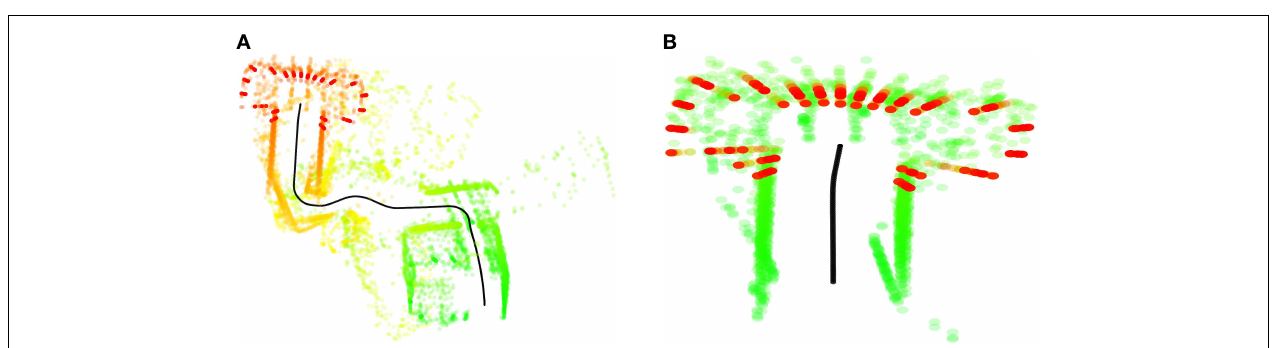
FIGURE 7 | Goal reaching frequencies for each condition .